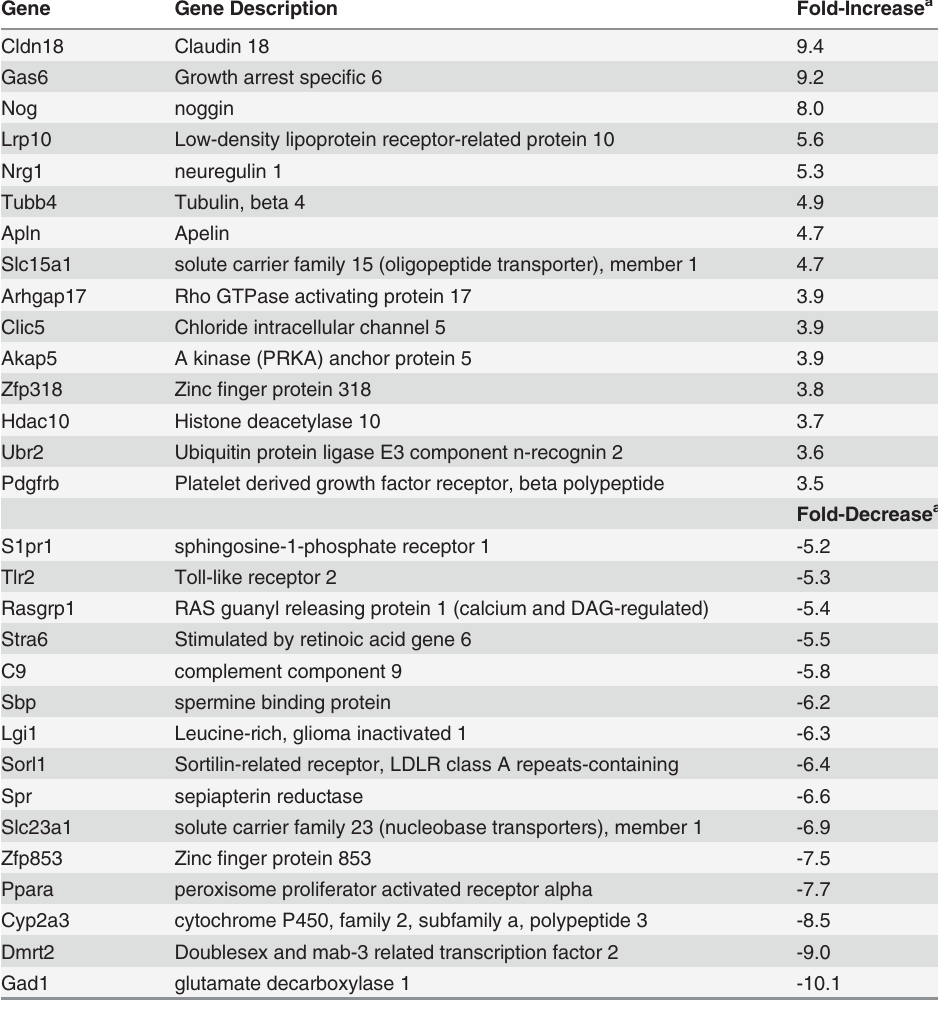
Table 3. Non-Fibrotic Bronchi: Major Changes in Gene Expression. Gene Gene Description Fold-Increase